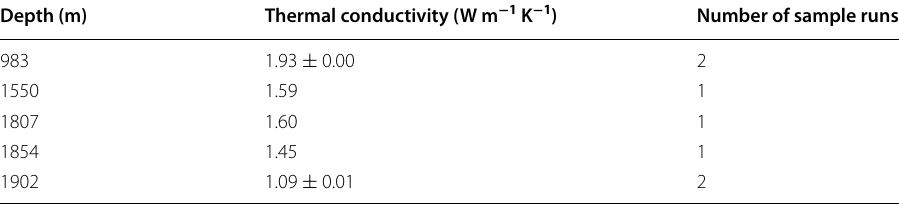
Table 1 Thermal conductivity measurements from